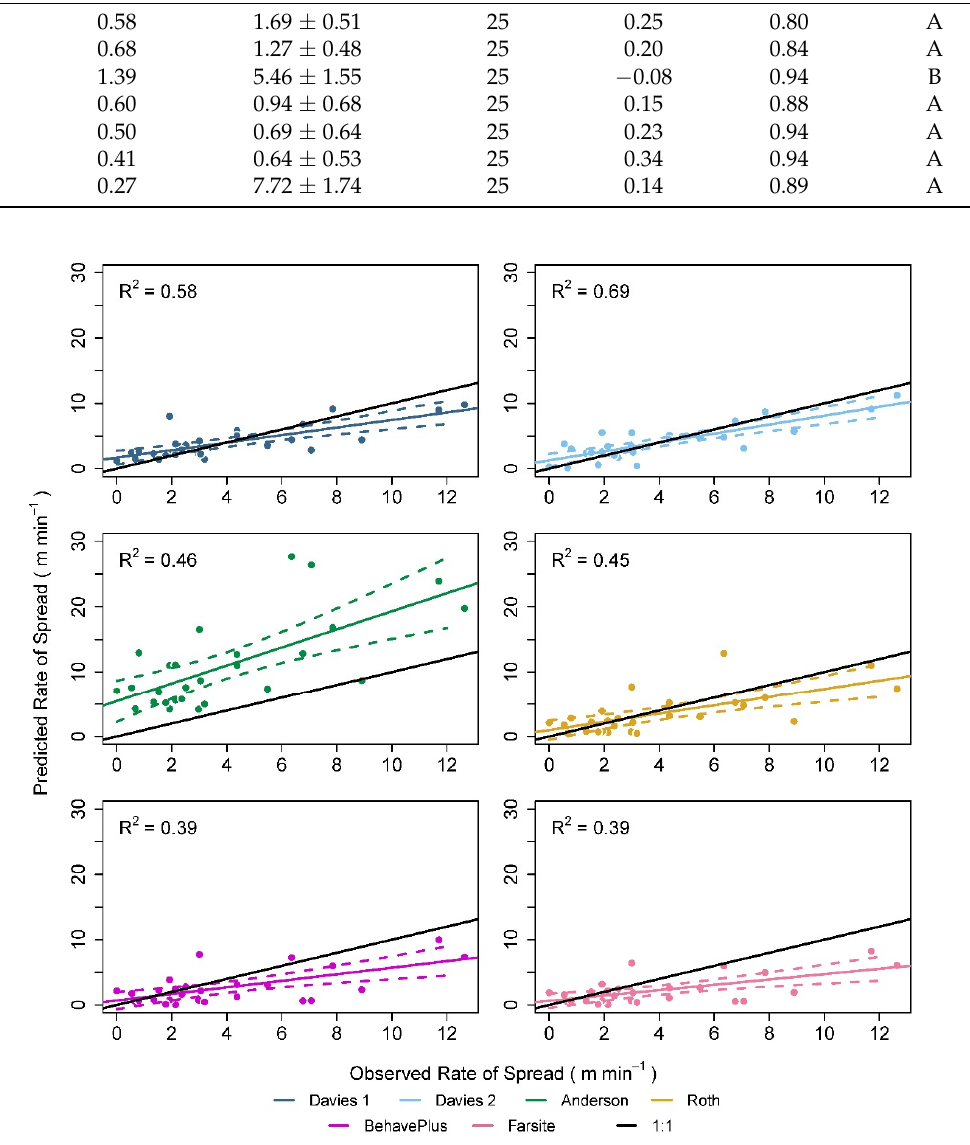
Figure 1. Results of linear regression analyses examining the relationship between predicted and observed rate of spread from six fire behaviour models. Coloured lines represent the regression and dashes represent 95% confidence intervals. The black line is the 1:1 LPA and individual observations of fire behaviour are shown as dots. Davies 1 and Davies 2 were built using the same fire behaviour observations; therefore, this analysis does not provide independent verification of their performance— these results are given to contextualize the performance of the other models. Further, the correction for Anderson is not shown as error was greatly